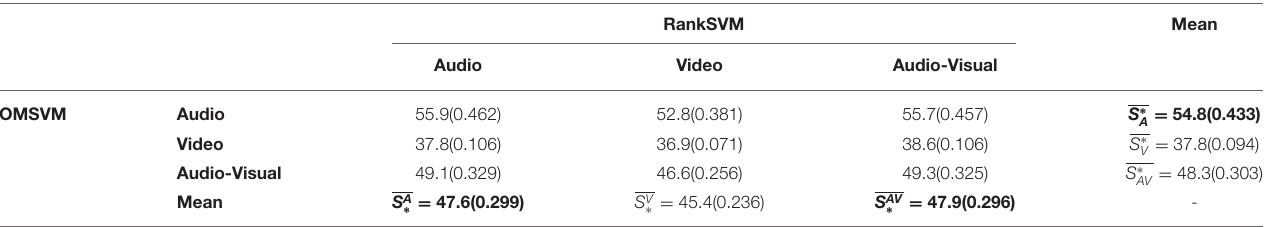
TABLE 6 | Performance of Arousal prediction in terms of Unweighted Average Recall (UAR %) and weighted kappa k w (reported inside parenthesis).